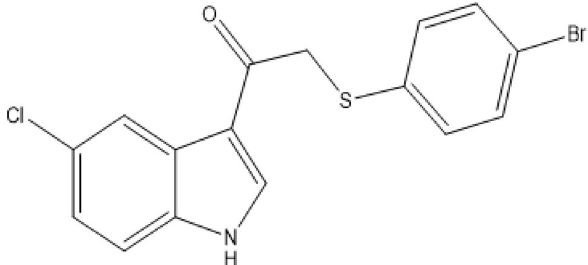
Fig. 3 Designed template, compound 22, 2-((4-bromophenyl)thio- 1-(5-chloro-1 H -indol-3-yl)ethanone, with pIC value of 0.240182, and standardized residual value of −